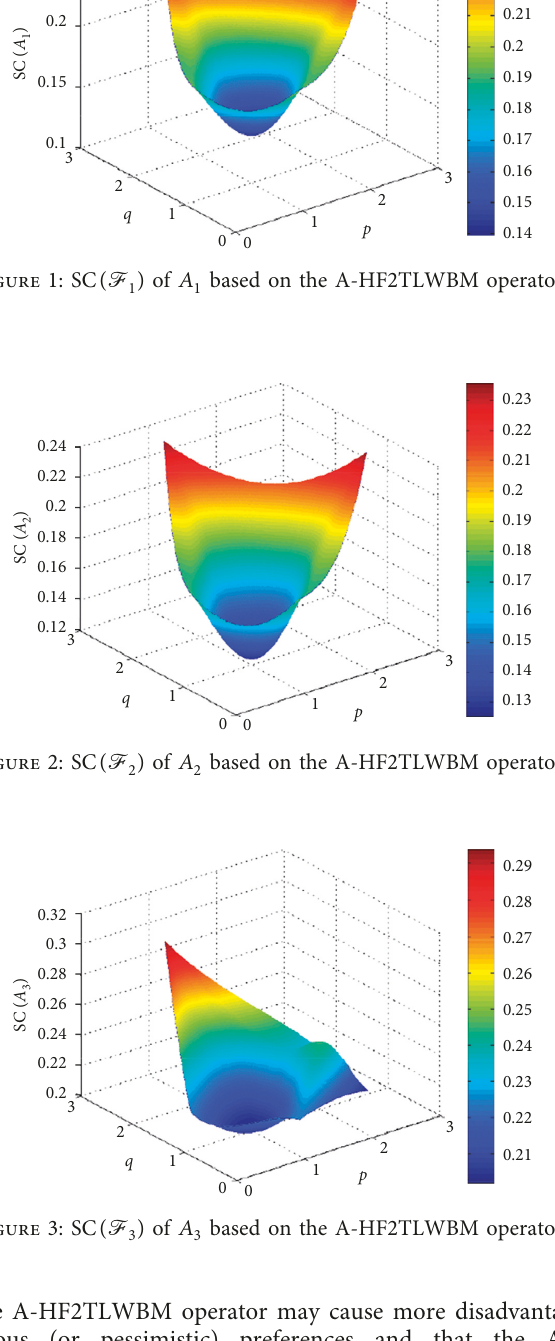
) of A based on the A-HF2TLWGBM operator. 1 1